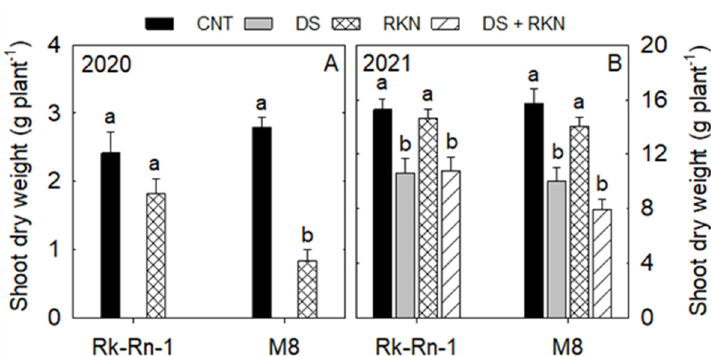
Figure 3. Drought and nematode effects on shoot dry weight ( A , B ) of cotton genotypes (Rk-Rn-1 and M8) measured under control (CNT), drought stress (DS), nematode stress (RKN), and DS + RKN combination in 2020 ( A ) and 2021 ( B ). Vertical bars denote mean ± SE. Means followed by a common letter are not significantly different by Duncan’s multiple range test at the 5% level of significance.